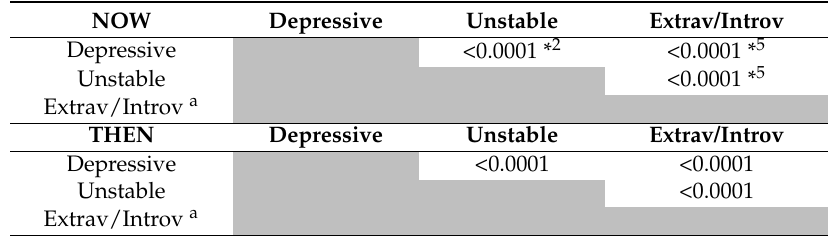
Table A14. Psychological